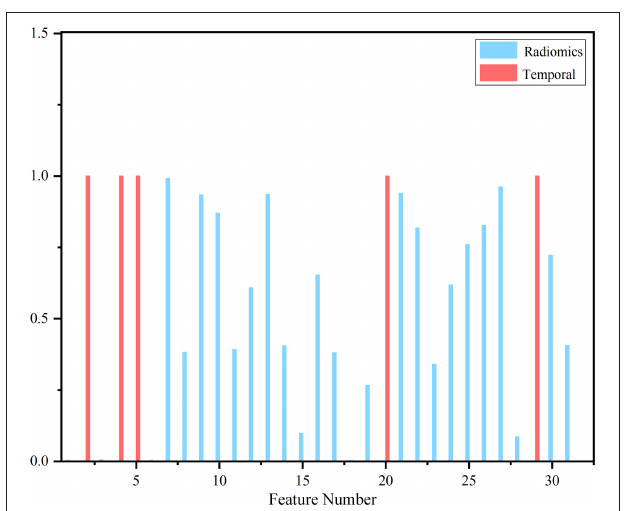
FIGURE 6 | Contribution of selected features. The red bar represented temporal features, and the blue bar corresponded to traditional static image featu res that clearly showed temporal features took precedence over most radiomics features.